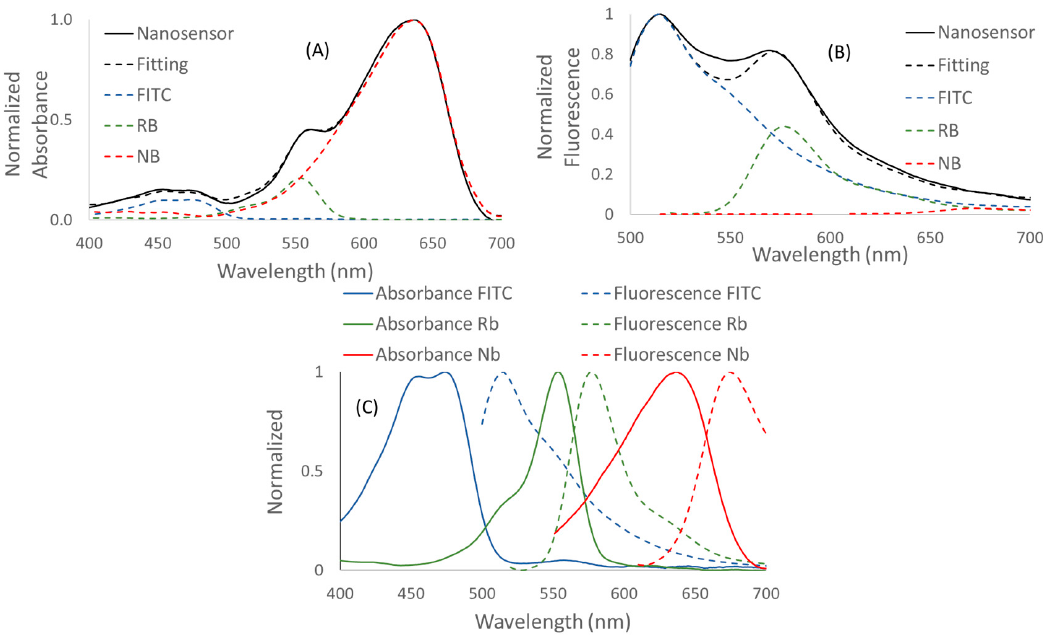
Figure 2. Spectral characteristics of nanosensors. ( A ) Normalized absorbance and ( B ) normalized fluorescence spectra of nanosensors. Individual component spectra of dyes used for fitting are shown. ( C ) Normalized absorbance/emission spectra of FITC, Rb and Nb